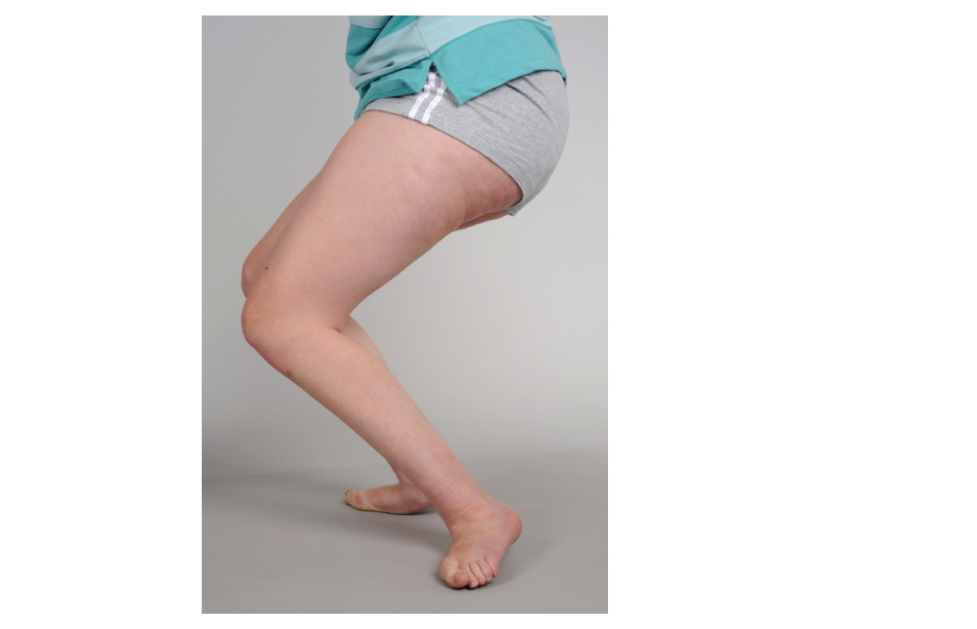
Figure 4. Decompensated pathology with severe crouch gait in a 15-year old girl with spastic diplegia, GMFCS IV (previously GMFCS III) There was no prior intervention apart from injections of BoNT-A. These are “natural history deformities”. The knee flexion contractures measured 45 degrees bilaterally, and the knees were flexed almost 90 degrees during gait. The feet had severe pes valgus and painful hallux valgus. The MAL team concluded that the MSP was Stage 4 with severe decompensation and advised that surgery was unlikely to be beneficial. Bilateral DFEOs and PTS were performed and were accompanied by neurovascular injuries, loss of ambulatory ability and deterioration in transfer ability.